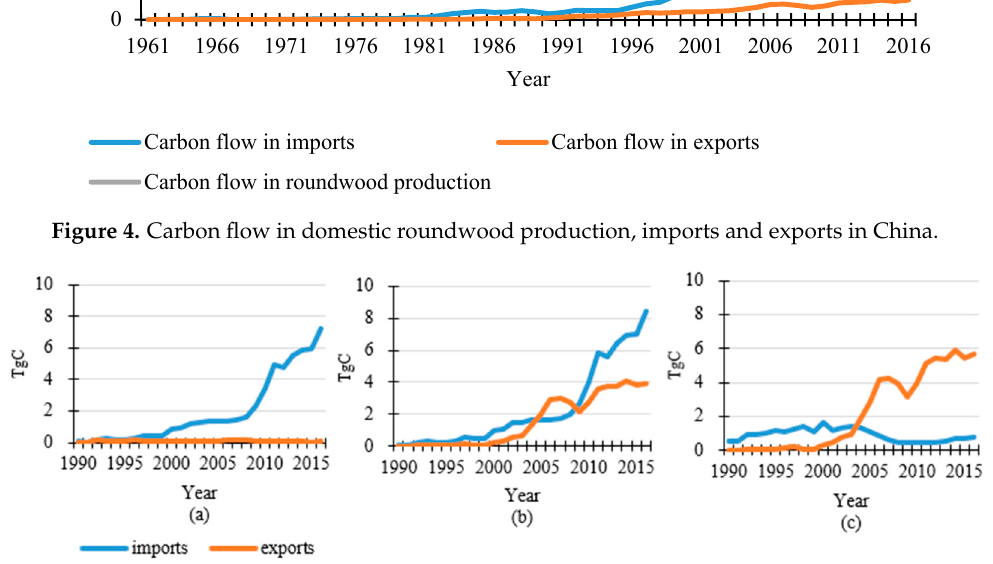
Figure 5. Trading carbon flow of semi-products in China. ( a ) Description of trading carbon flow of sawnwood in China; ( b ) Description of trading carbon flow of wood-based panels in China; ( c ) Description of trading carbon flow of paper & paperboard in China.